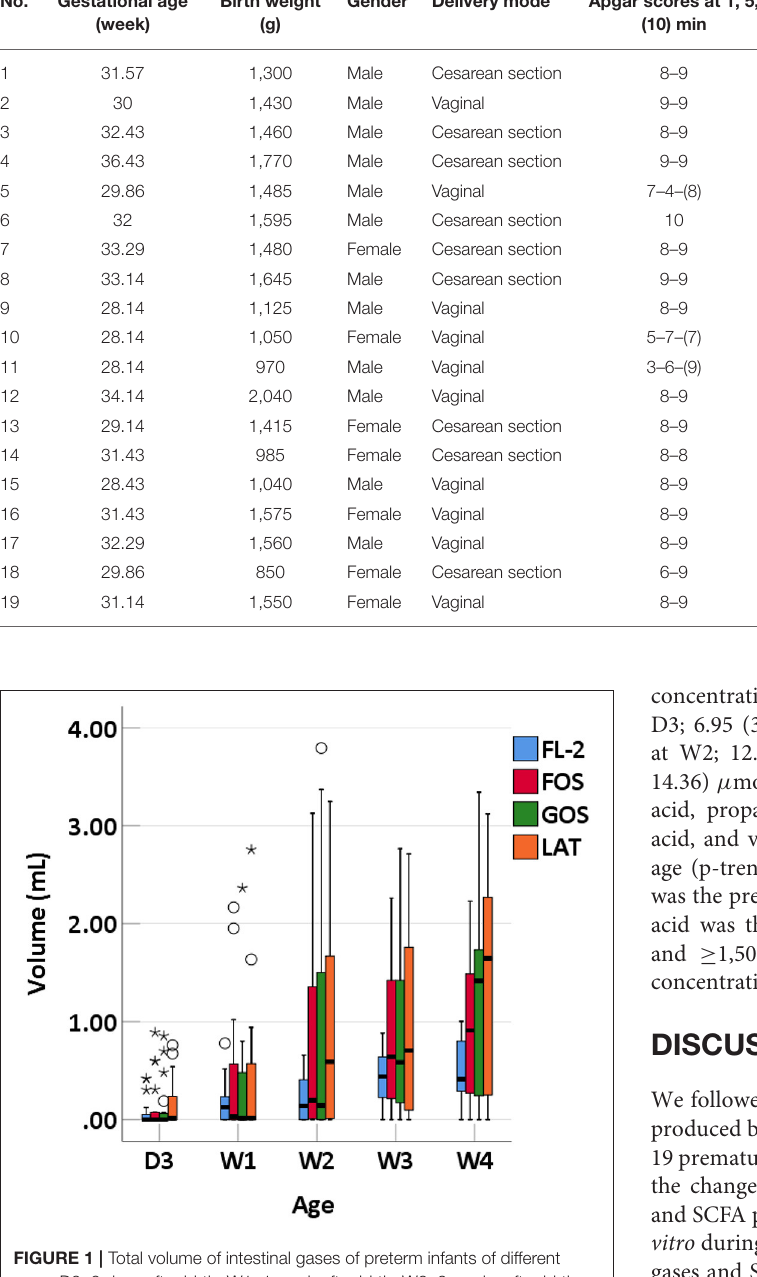
µ mol/g at W3; and 10.09 (2.56–19.25) µ mol/g at W4. In